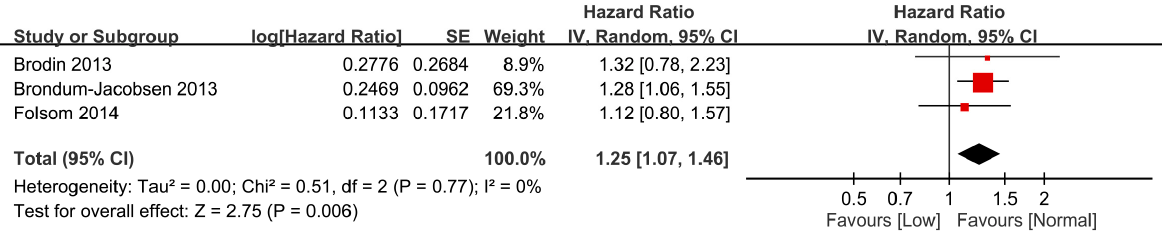
Figure 4. Forest plot comparing the overall risk of venous thromboembolism based on a time-to-event analysis between participants with and without a low vitamin D status. CI, confidence interval; SE, standard error.The measure of effect (e.g., an odds ratio) for each of these studies is represented by a square incorporating confidence intervals represented by horizontal lines. The vertical line is “Line of no effect”. The area of each square is proportional to the study’s weight in the meta-analysis. This meta-analysed measure of effect is plotted as a diamond, the lateral points of which indicate confidence intervals for this estimate.[7,19,20]